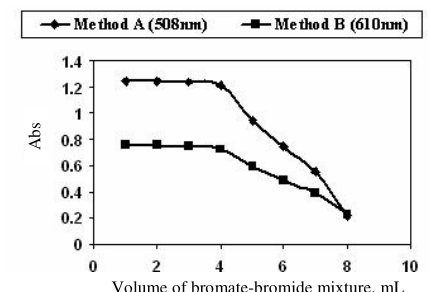
Figure 5. Method A at 5 × 10 −5 M of STS and bromate-bromide mixture (5 × 10 −5 M w.r.t KBrO ) and Method B at 1 × 10 −4 M of STS and bromate-bromide mixture (1 × 10 −4 M w.r.t 3 KBrO ) 3